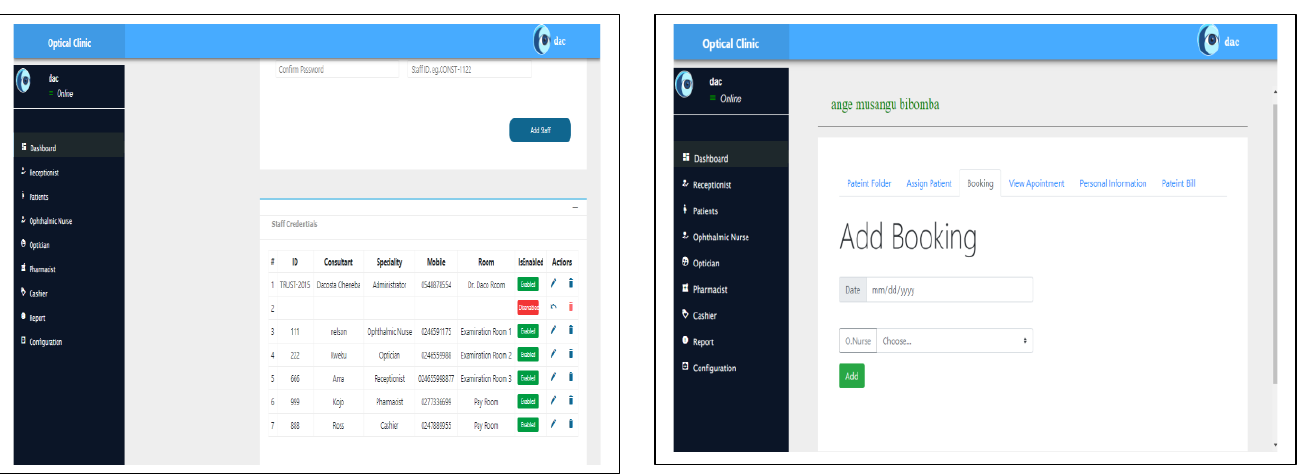
Figure 19. Staff Access Control Interface